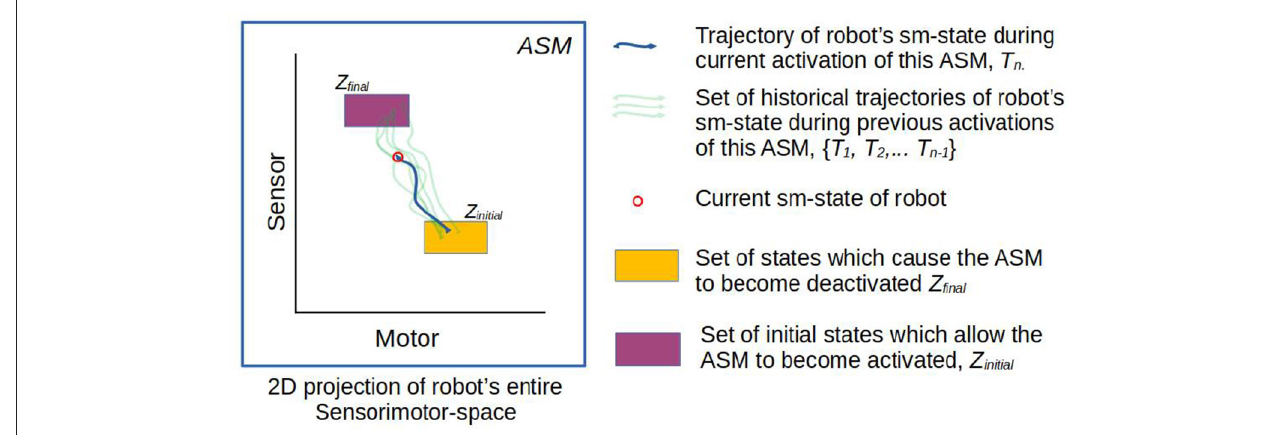
FIGURE 3 | Simplified visualization of an ASM-unit in operation. The model essentially stores a number of historical trajectories in this space which have passed from the within range initial state to the range of final states, and utilizes information about those trajectories to generate motor activity for the robot in its current